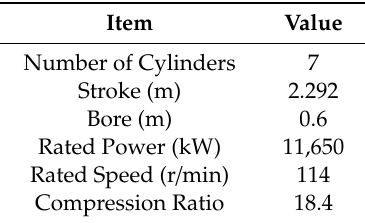
Table 1. Data of the test engine.